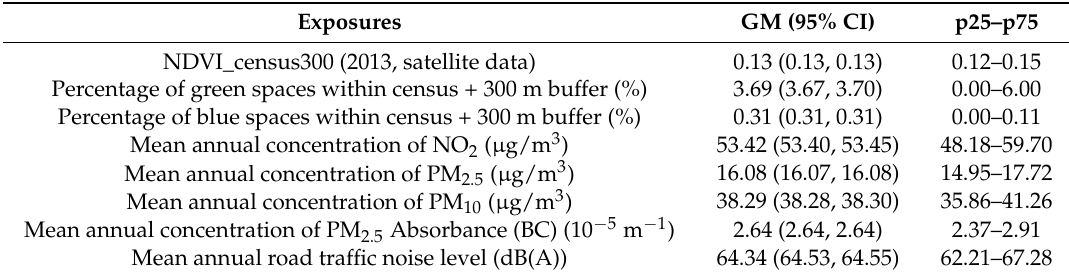
Table 2. Average exposure of the census tracts in Barcelona.